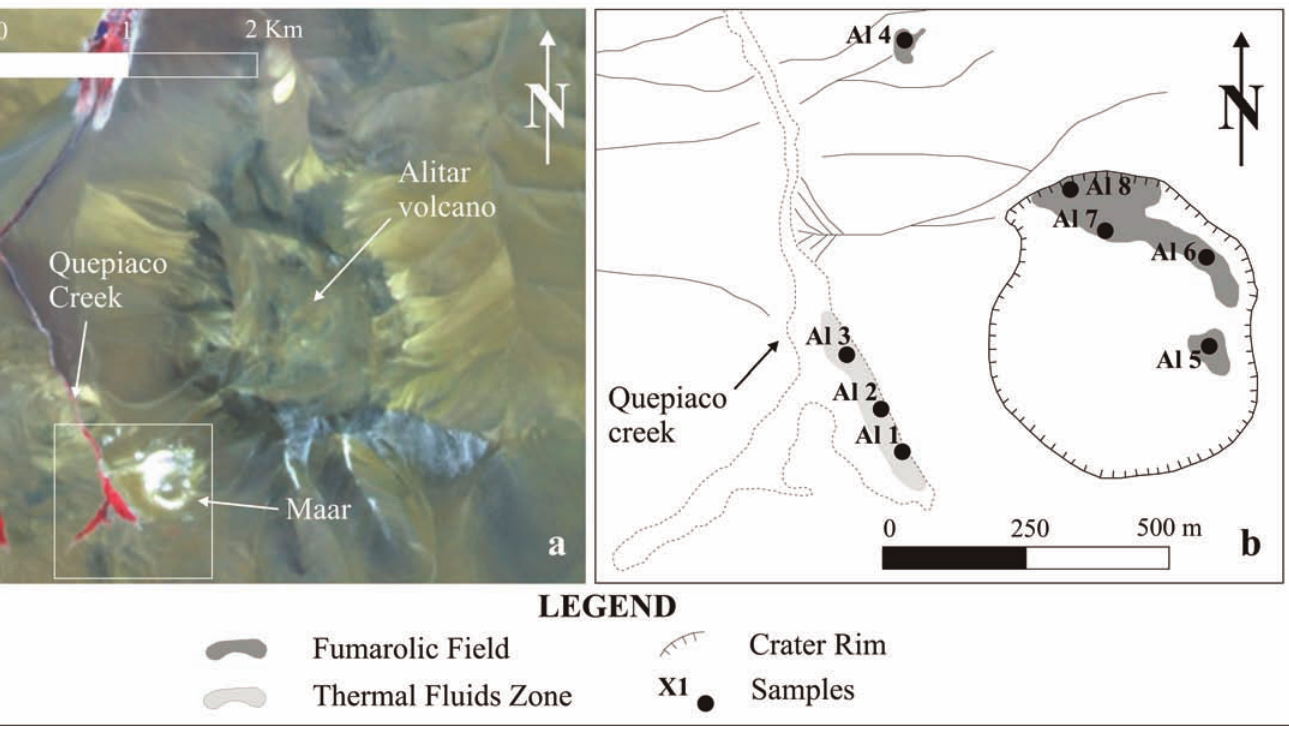
Figure 5. Aerial photograph (a) and schematic map (b) of the summit crater of Alitar volcano, showing the locations of the fumarolic fields and sampling